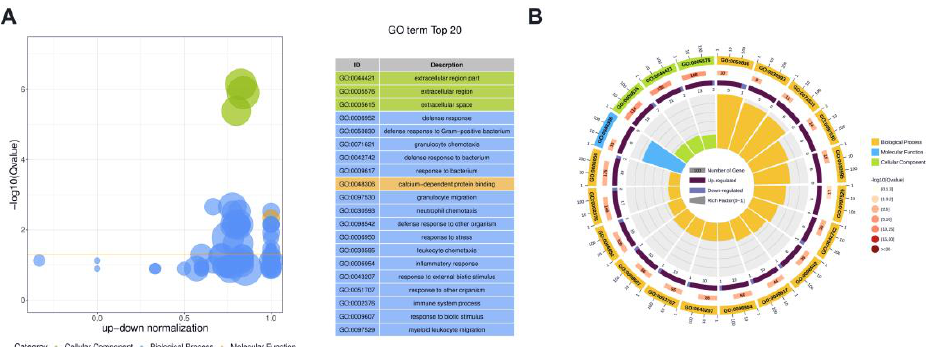
Figure 4. The overview of the top 20 most significant GO terms between CM and Healthy group (Q value < 0.05). ( A ) The bubble plot assigns the z- score to the x -axis and the negative logarithm of the adjusted p -value to the y -axis. The area of circles is proportional to the number of genes assigned to the term, and the color corresponds to the category. ( B ) In the circular barplot from outer to inner, the circle displays three categories; the length represents the total gene number; the color represents Q-value; the area represents the RichFactor value of each category. We used the Reactome pathways analysis tool to analyze the pathways potentially impacted by DE proteins between the CM and Healthy group (Table 3). Neutrophil Degranulation was the most significant (FDR < 0.0005) reaction with 16 gene counts, followed by the Innate Immune System with 20 gene counts. The antimicrobial peptides pathway was another significant reaction with 5 gene counts. DE proteins were also associated with RHO GTPases Activate NADPH Oxidases, RHO GTPases Activate WASPs and WAVEs, RHO GTPase Effectors, etc. Details were reported in Supplementary File Table S8. There were 16 proteins, including Granulin precur- sor, Protein S100-A9, Cytochrome b-245 light chain, Protein S100-A12, C5a anaphylatoxin chemotactic, Peptidoglycan recognition protein 1, Leukocyte elastase inhibitor, Protein S100-A8, Syndecan binding protein, MPO protein, SERPIN domain-containing protein, Cathelicidin-4, Olfactomedin 4, STOM protein, Integrin beta-2, and High-affinity immunoglobulin epsilon receptor subunit gamma, commonly contributed to Neutrophil Degranulation and Innate Immune System. Other 4 proteins, such as Actin-related protein 2/3 complex subunit 1B, Clusterin, Actin-related protein 2/3 complex subunit 2, and Cytoplasmic FMR1-interacting protein, uniquely contributed to the Innate Immune System. The increased pathway antimicrobial peptides were consistent with elevated Cathelicidin- 4, Protein S100-A9, Peptidoglycan recognition protein 1(PGLYRP1), Protein S100-A12, and Clusterin — DE proteins found specifically enriched in the CM group.